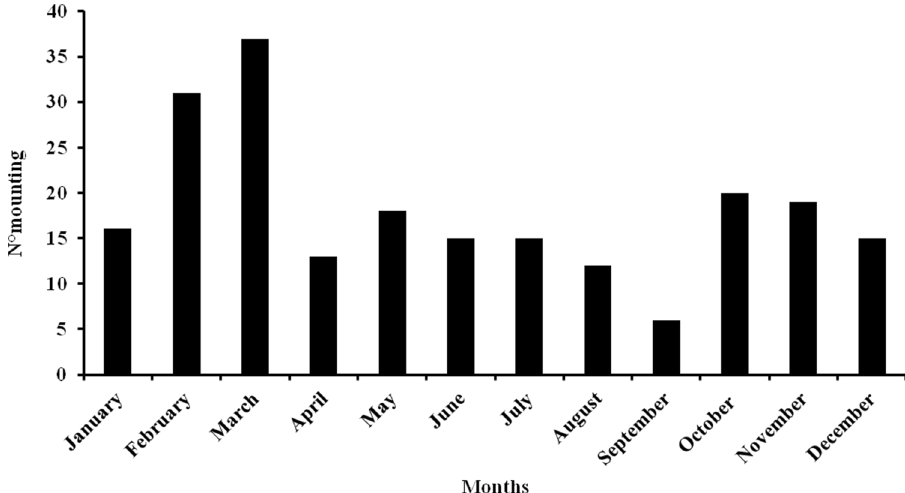
Figure 2. Total number of recorded mounting events per month for all the 8 monitored porcupine pairs during the 3 years of monitoring.